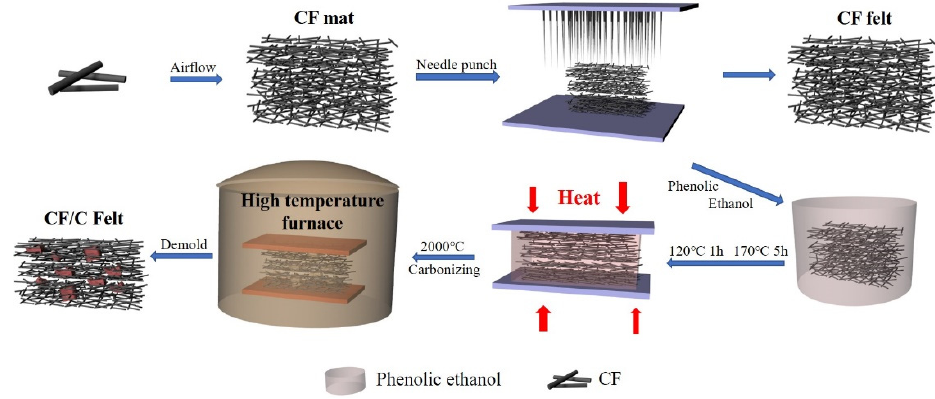
Figure 1. The preparation process of the carbon fiber (CF) felt and CF/C